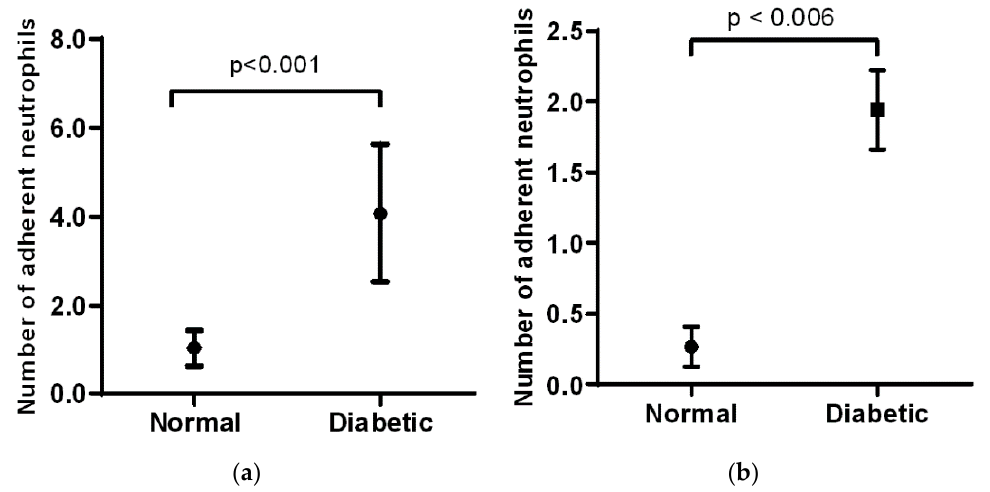
Figure 2. Mean values (± standard deviation) of adherent neutrophils in the cremaster ( a ) and ear lobe ( b ) in normal and diabetic mice ( n = 6) over a period of 5 months. Overall, diabetic mice exhibited an increased number of adherent neutrophils compared to that of normal mice.